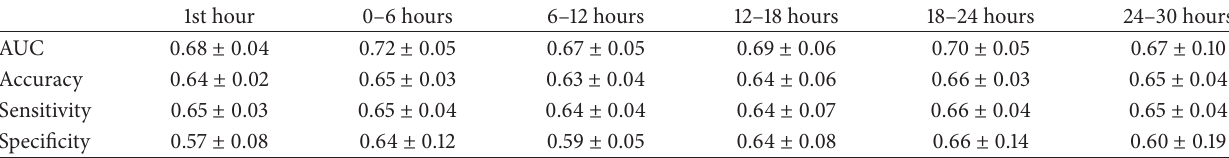
Table 2: Performance of the fuzzy model using different, nonoverlapping, 6-hour intervals during the first 30 hours after ICU admission.